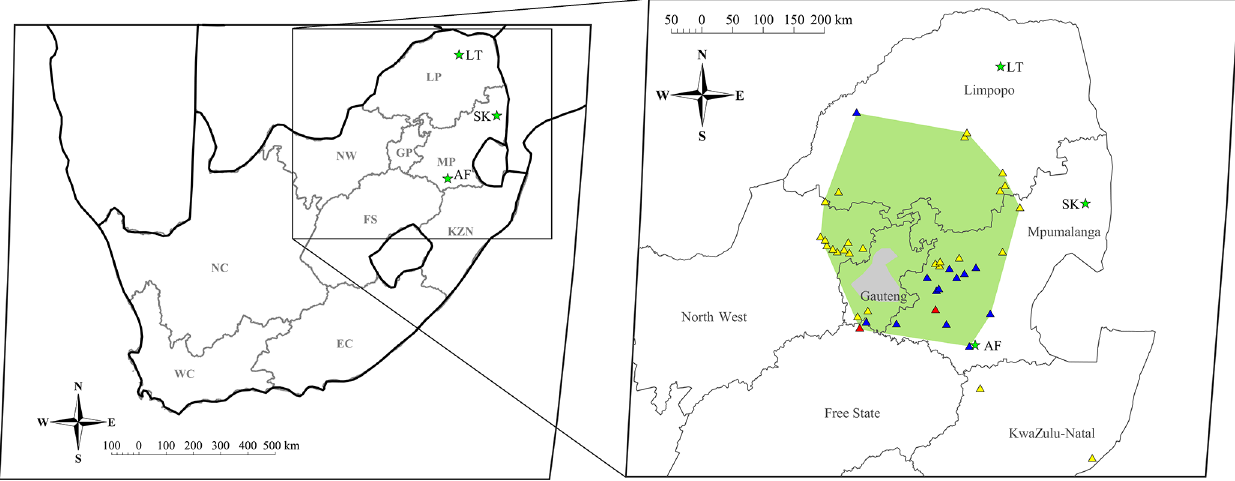
Figure 1. Regional map of South Africa indicating the measurement sites at Amersfoort (AF), Louis Trichardt (LT) and Skukuza (SK) with green stars. A zoomed-in map indicates the defined source region, the Johannesburg–Pretoria conurbation (grey polygon) and large point sources, i.e. power stations (blue triangles), petrochemical plants (red triangles) and pyrometallurgical smelters (yellow triangles).